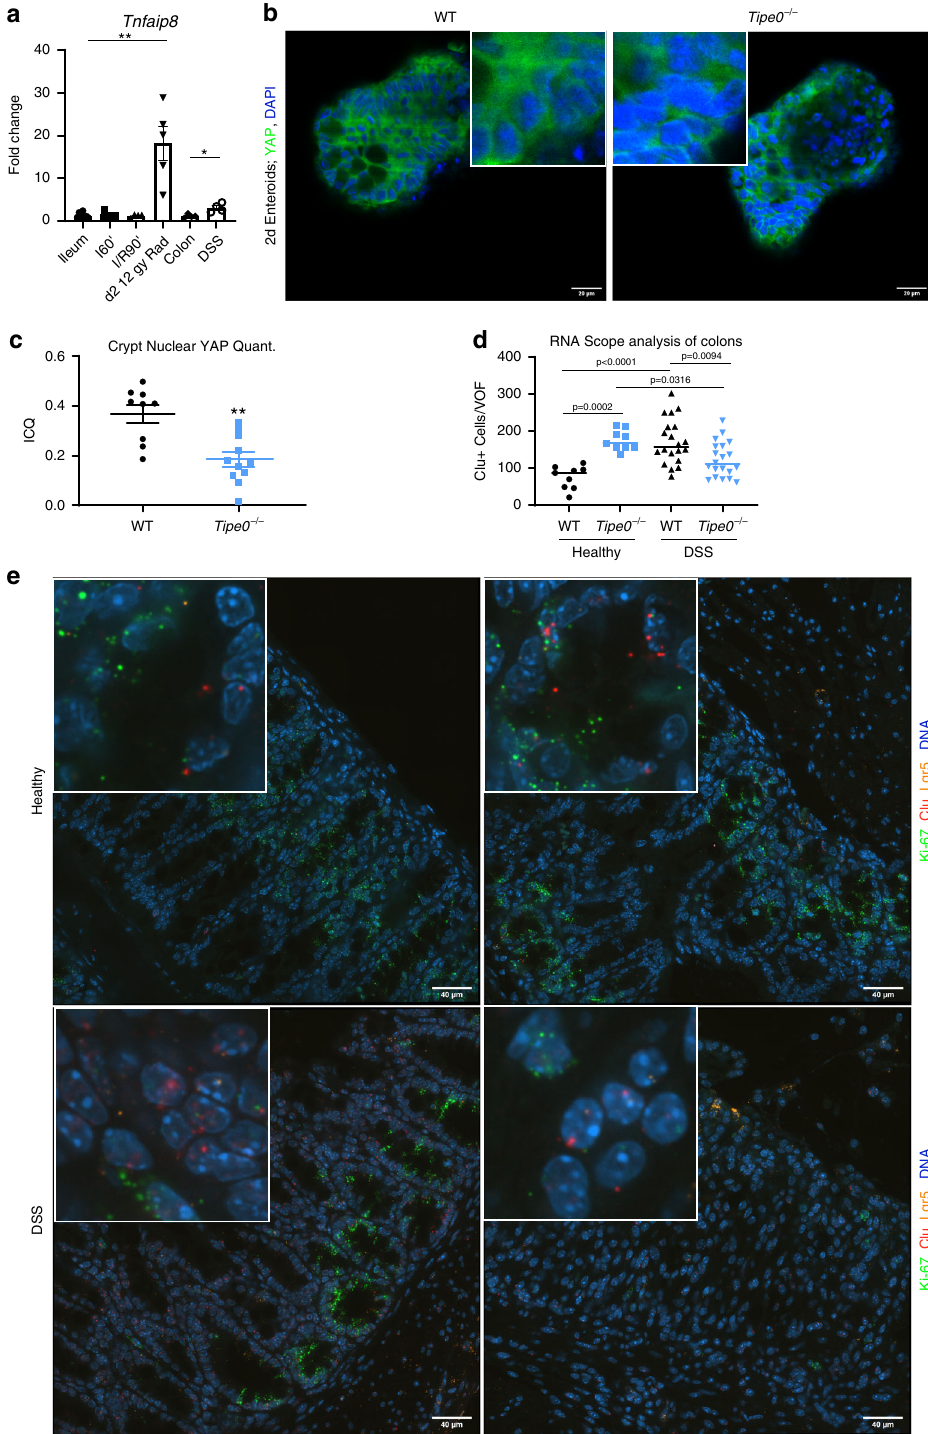
Fig. 7 Nuclear YAP localization is inhibited in budding Tipe0 − / − enteroids while Clu is induced in Tipe0 − / − colons. a RT-PCR assay for Tnfaip8 (variant 1) gene expression. N = 8 for WT ileum, fi ve for radiation, and four for all other groups; p = 0.0016 for radiation, p = 0.0286 for DSS. YAP staining in 2-day enteroids, bars = 20 µ m; insert is 3× magni fi ed, with quanti fi cation of nuclear YAP by ICQ in developing crypts ( c ). N = 10 for WT, N = 12 for Tipe0 − / − , pooled from two independent experiments, with images representative of those quanti fi ed; p = 0.0016. d , e RNAscope Clu + cells in mice WT and Tipe0 − / − mice, before and after DSS treatment with additional staining for Ki-67, Clu, and Lgr5, with DAPI counterstain. Ki-67 and Lgr5 are used as controls to identify enterocyte speci fi c staining for further quanti fi cation ( d ). For healthy tissues, N = 9/group (3 mice/group, with 3 images/group analyzed). For DSS tissues, N = 20 ( fi ve images each from N = 4 mice/group were analyzed). Images are representative of those quanti fi ed; Bars = 40 µ m; insert is 5× magni fi ed. e Data analyzed one-way ANOVA with Sidak ′ s multiple comparison test. For all graphs, data analyzed by two-tailed Mann – Whitney U test unless otherwise speci fi ed; * p < 0.05; ** p < 0.01 vs WT; error bars show mean ± SEM. Source data are provided as a source data fi